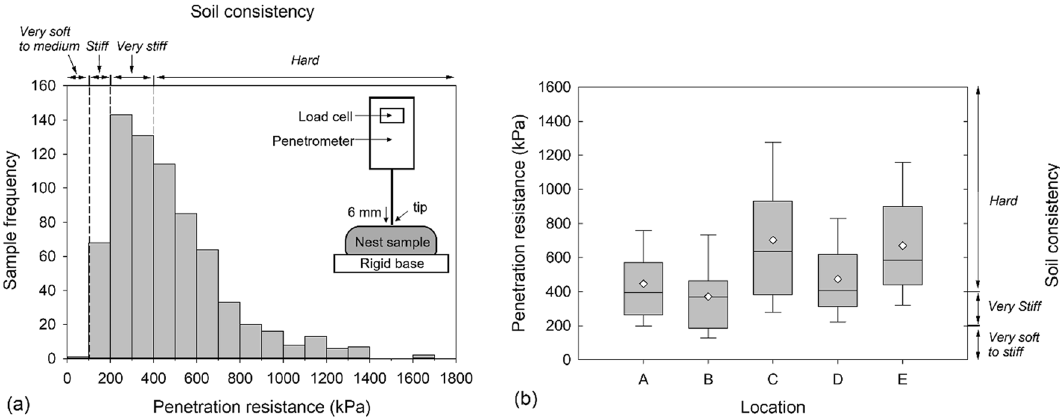
Figure 2. Penetrometer tests: ( a ) the histogram of penetration resistances of collected mud dauber nest samples and ( b ) box plot of penetration resistances by sample collection locations. The terms to describe soil consistency include: hard (greater than 400 kPa), very stiff (between 200 and 400 kPa), stiff (between 100 and 200 kPa), medium (between 50 and 100 kPa), soft (between 25 and 50 kPa), and very soft (less than 25